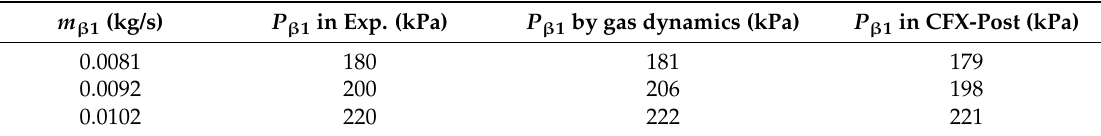
Table 2. The relationship between steam inlet mass flow rate and corresponding pressure for different calculation